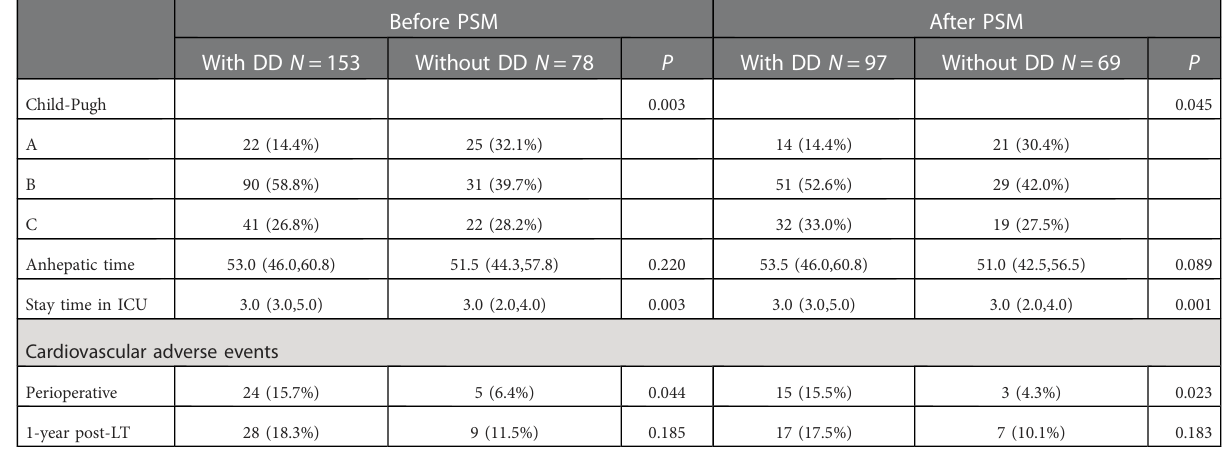
TABLE 4 Comparison of scoring-based estimation and procedure-related data between patients with and without DD.